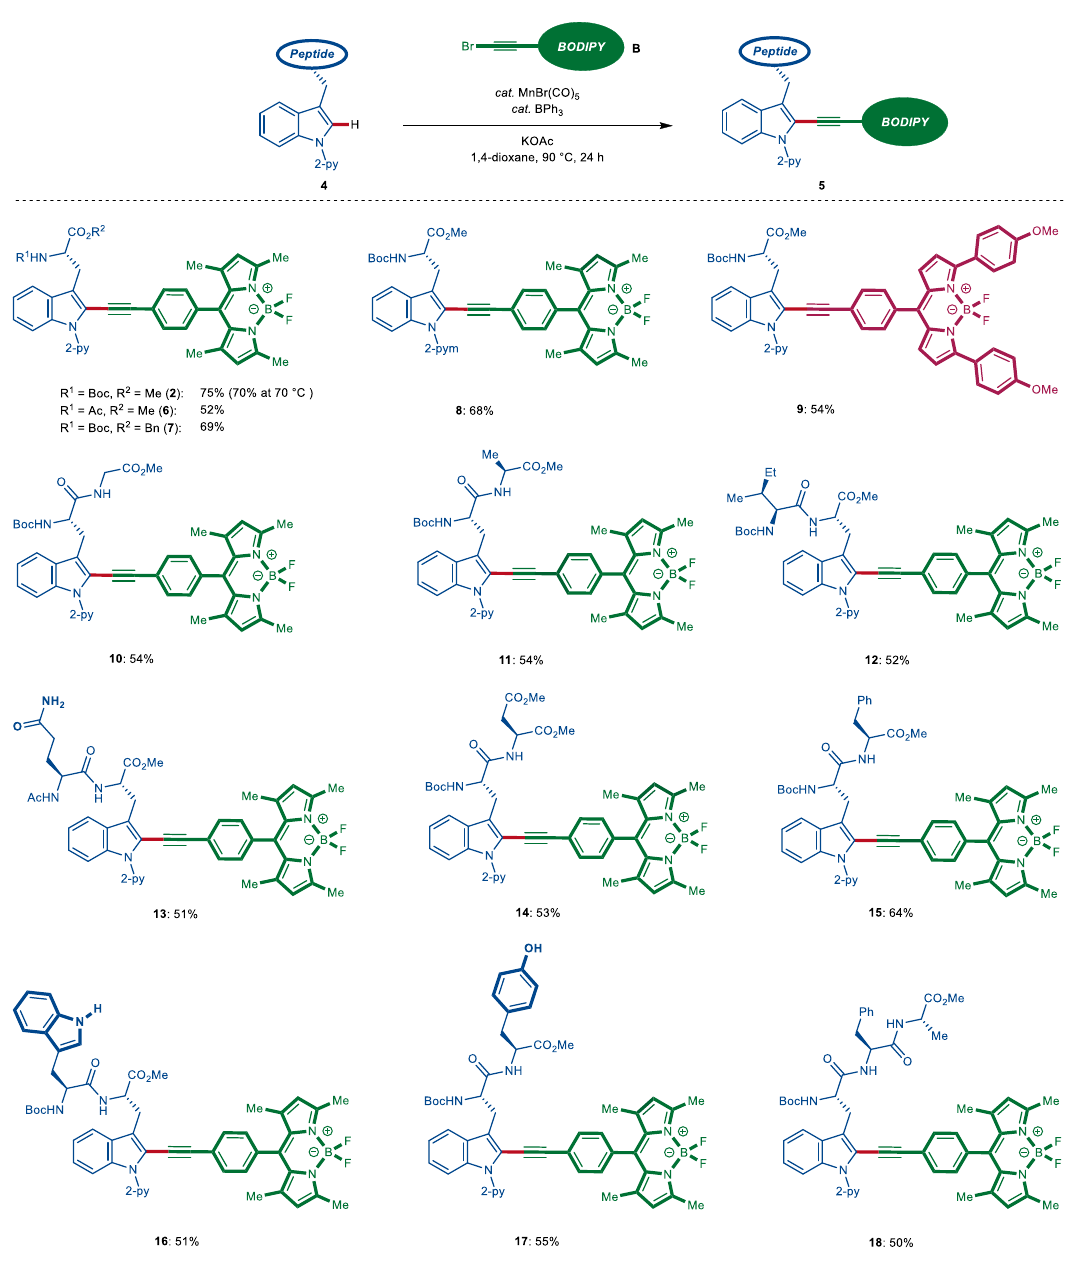
Fig. 2 Manganese-catalyzed fl uorescent labeling of small peptides via late-stage C – H stitching. Synthesis of peptides 6 – 18 featuring a linear linker between the BODIPY fl uorophore and the tryptophan amino acid via C – H